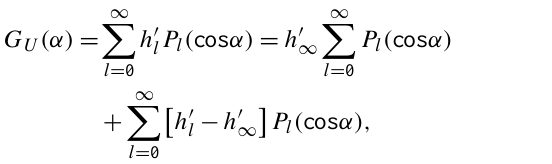
Figure 1. Example of unstructured mesh at earth surface. Both the (a) Northern and (b) Southern Hemisphere are shown, with continents depicted in cyan. This mesh is generated using Gmsh (Geuzaine and Remacle, 2009), with the BAMG mesh refinement algorithm (Hecht, 2006). The mesh refinement metric employed here is a function of the distance from the nearest